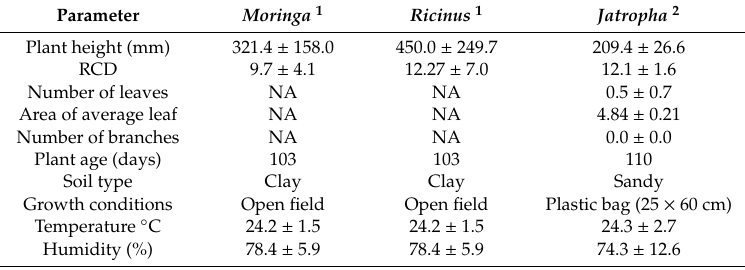
Table 5. Mean (± SD) aboveground data of Moringa oleifera , Ricinus communis , and Jatropha curcas , and their environmental conditions documented during previous research at the site.